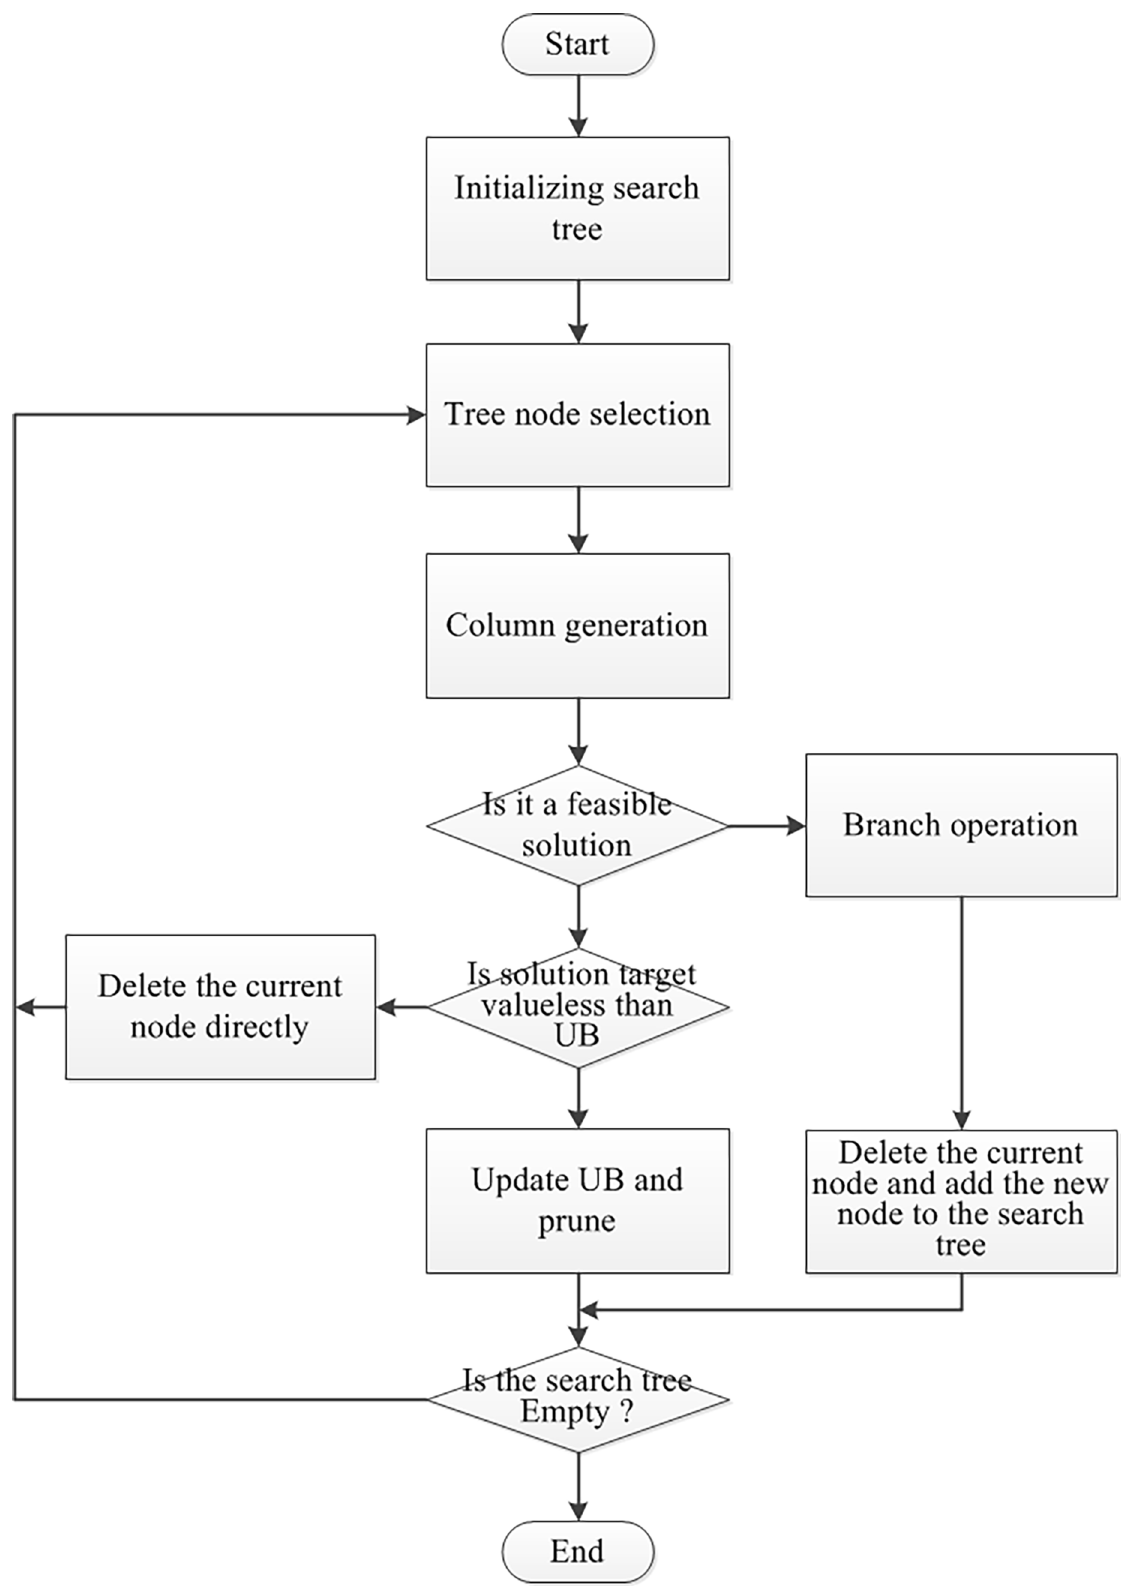
Fig 2. Branch-and-price algorithm